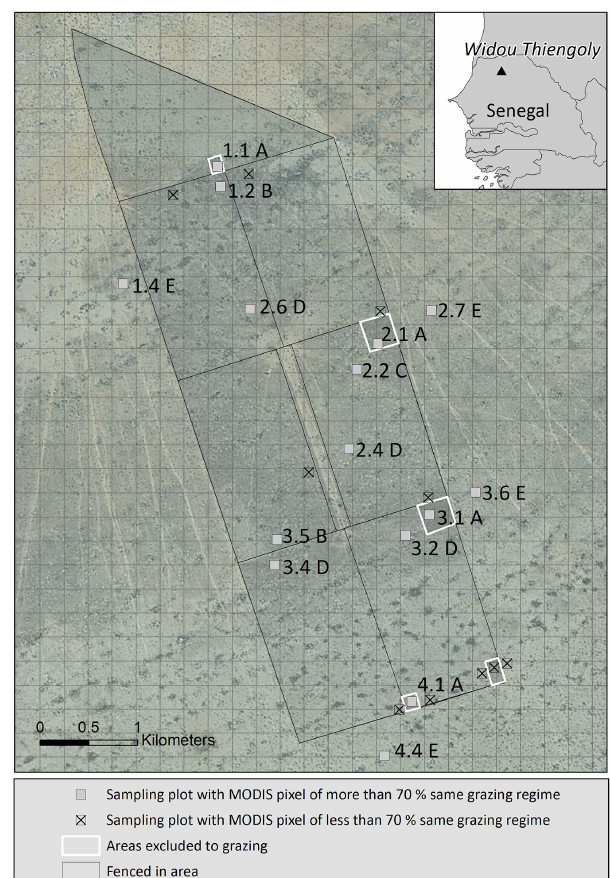
Figure 1. Site overview including sampling plots, rain gauges, and grid representing 250m MODIS pixels. Plot labels include plot numbers and grazing intensity (A = no grazing, B, C or D = controlled grazing, E = communal/free grazing). The high res- olution background imagery was printed from Google Earth (2014 Google – Cnes/Spot Image, Digital